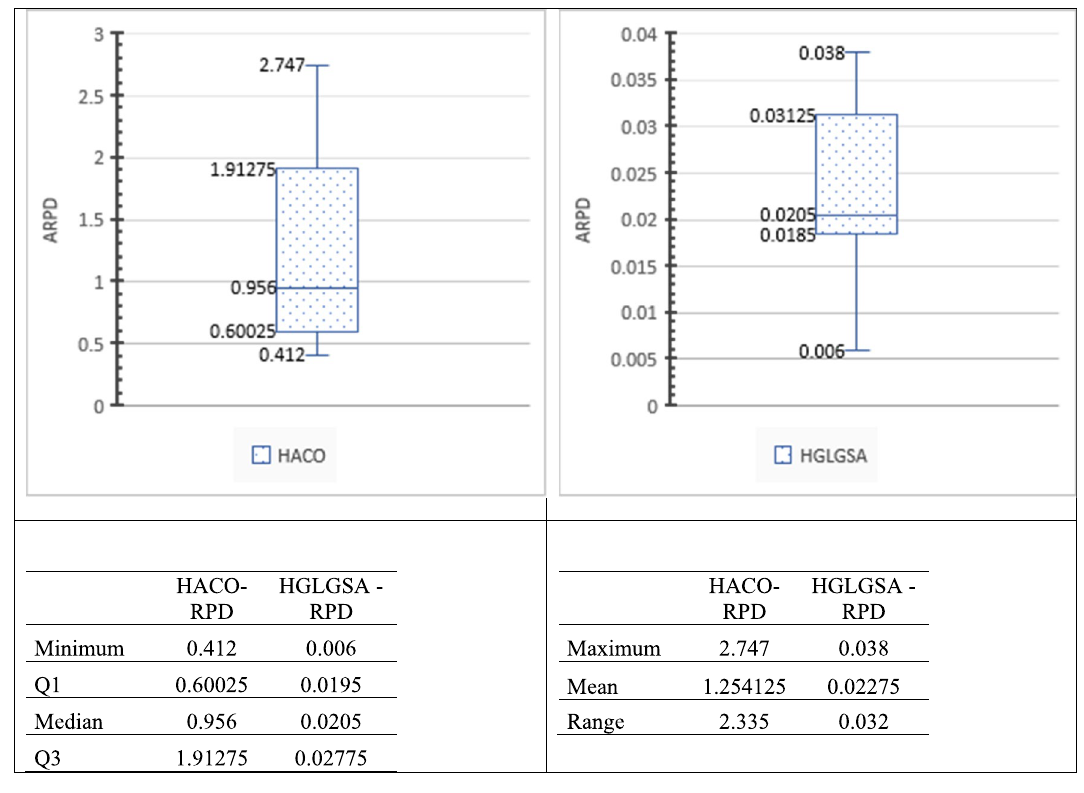
Fig. 6 Box plots for the average RPD values